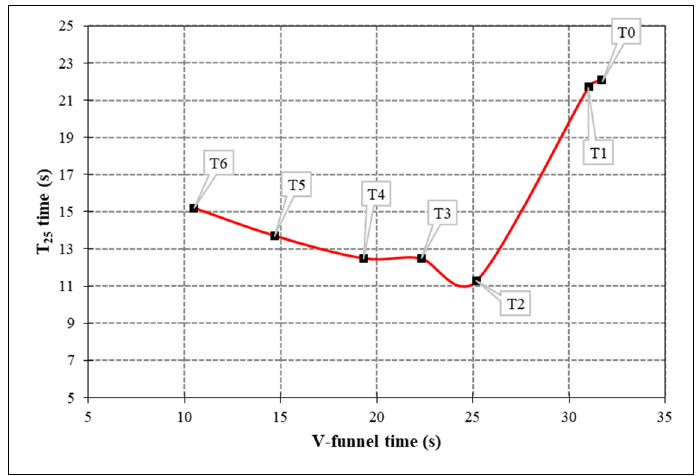
Figure 3. Relationship of V-funnel time with T 25 with varying silica fume content.